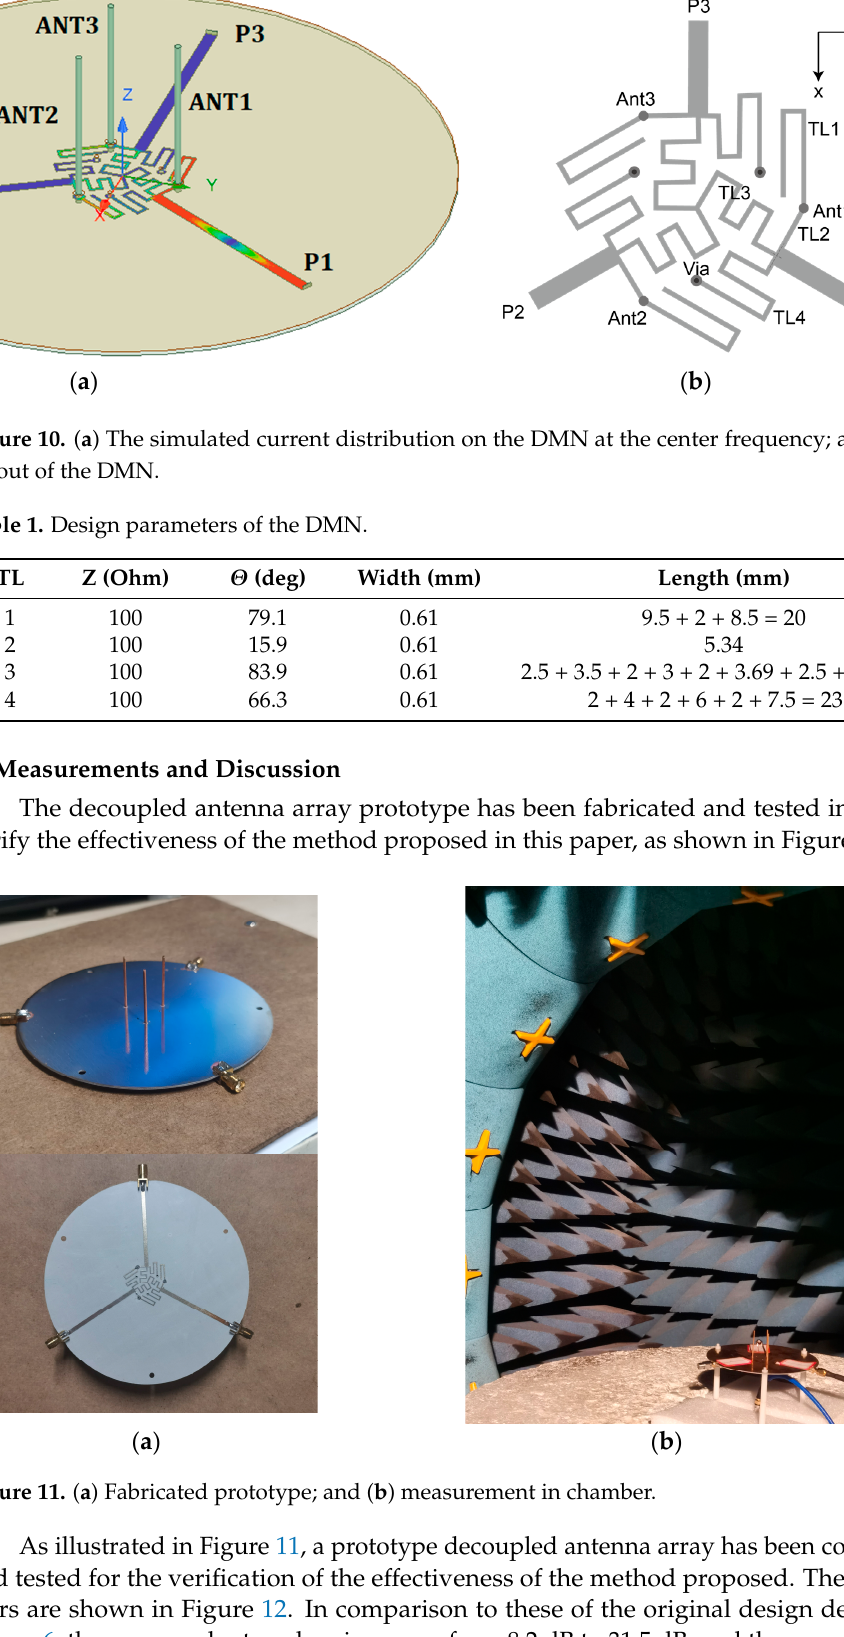
Figure 12. The S parameters of the decoupled array.